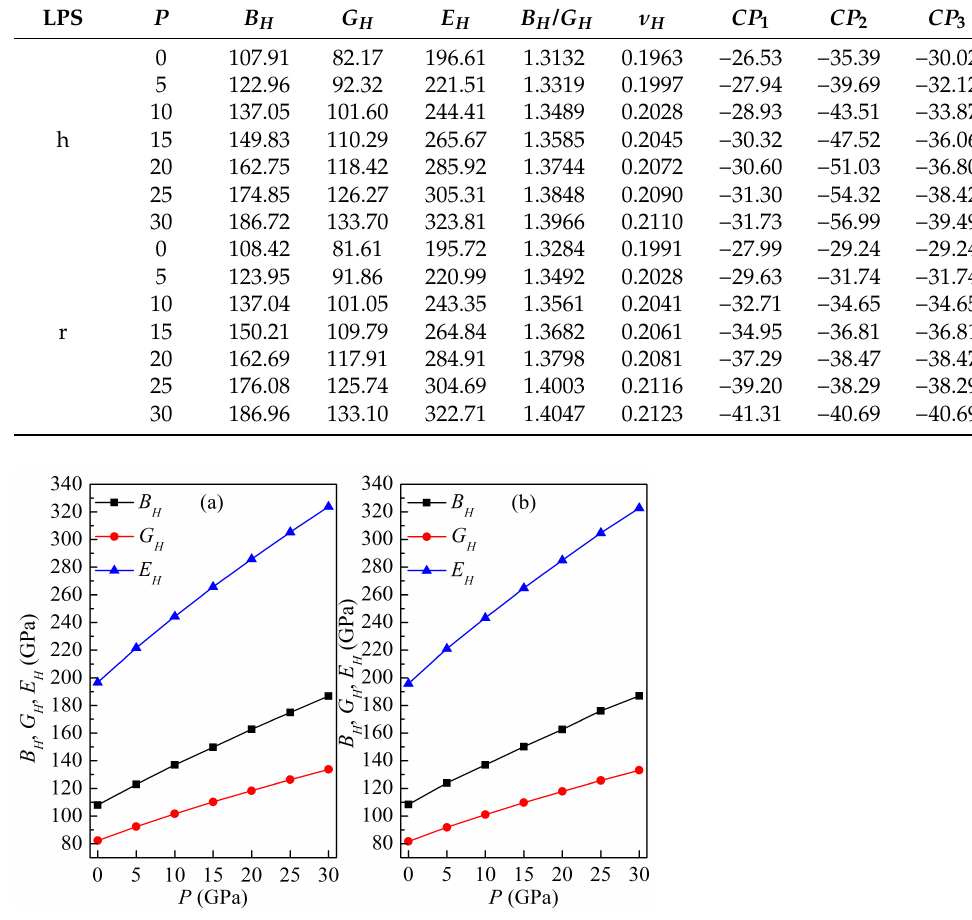
Figure 5. Elastic moduli of the LPSs ( a ) h-Al 2 Ti and ( b ) r-Al 2 Ti as a function of pressure at 0 K. The present orientation dependence of bulk modulus for the LPSs h- and r-Al 2 Ti under pressure up to 30 GPa at 0 K are shown in Figure 6 and Figure 7, respectively. For these three-dimensional (3D) representation surfaces, the size of the bulk modulus is denoted by the length of the radius vector in arbitrary crystallographic directions and different colors. The 3D surface of an isotropic system must be a spherical shape with a color, and the nonsperical shape with different colors indicates the degree of anisotropy. Clearly, the directional dependences of B for both LPSs under any pressure at 0 K illustrate nonspherical 3D shapes with various colors, indicating their intrinsic anisotropies. The obtained maximal ( B max ) and minimal ( B min ) values and the B max / B min ratio of bulk modulus for both LPSs under pressure up to 30 GPa at 0 K are listed in Table 5. One can find that the B max and B min values of both LPSs at 0 K increase gradually with increasing the pressure. The B max / B min ratios of both LPSs, which are slightly greater than one in the studied entire pressure range, are also found to increase on the whole with increasing the pressure, indicating that